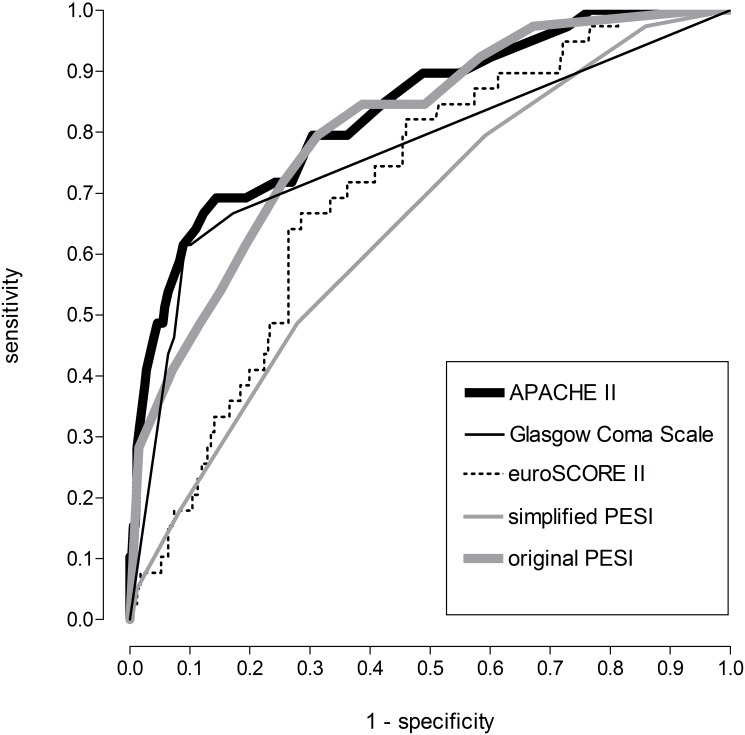
Receiver operating characteristic curve of clinical scores and their ability to predict 30-day mortality on patients with acute pulmonary embolism.